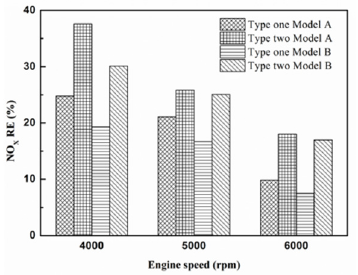
Figure 34. The NO x RE at control voltage 5 V.